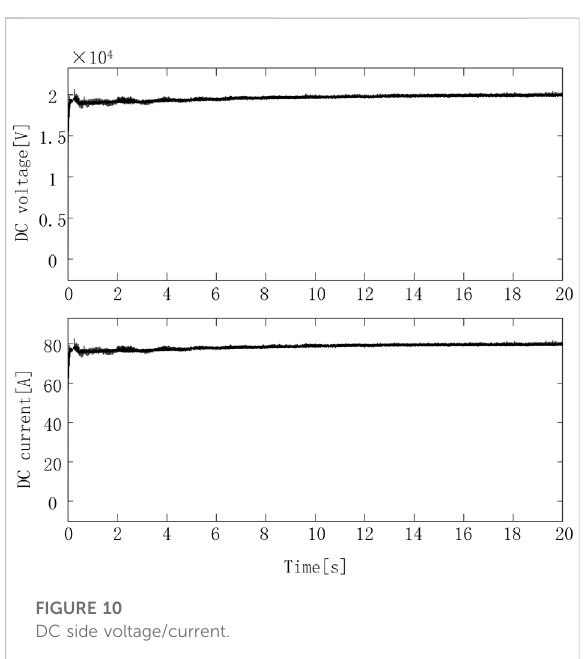
FIGURE 10 DC side